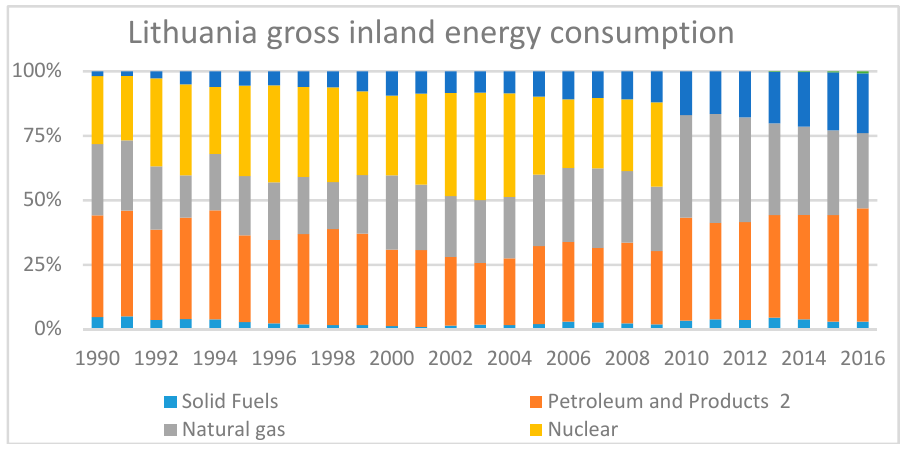
Figure 9. Gross inland energy consumption structure dynamics in Lithuania, %. Source: [39].